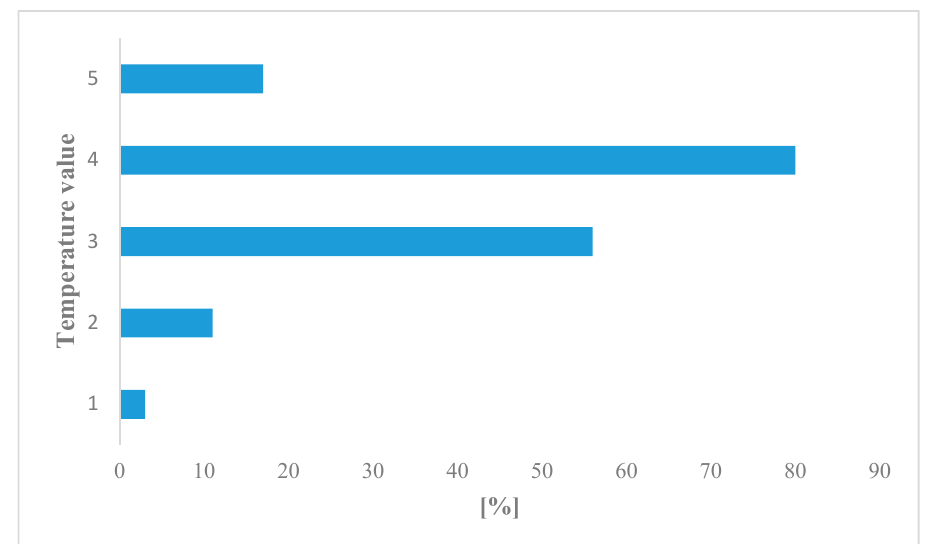
Figure 5. Plant requirement with respect to temperature: (1) coldest climatic conditions, (2) moderately cold areas, (3) moderately cool climatic conditions, (4) moderately warm climatic conditions, (5) warmest regions and microhabitats.